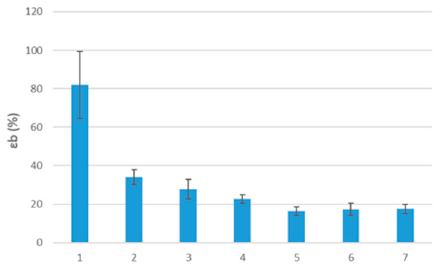
Figure 14. Young’s modulus. Samples: (1) HDPE, (2) HDPE with 20% filler content, (3) HDPE with 40% filler content, (4) HDPE with 50% filler content, (5) HDPE with 60% filler content, (6) HDPE with filler content 70%, (7) HDPE with a filler content of 80%.